Question: Summarize what this figure shows in one sentence.
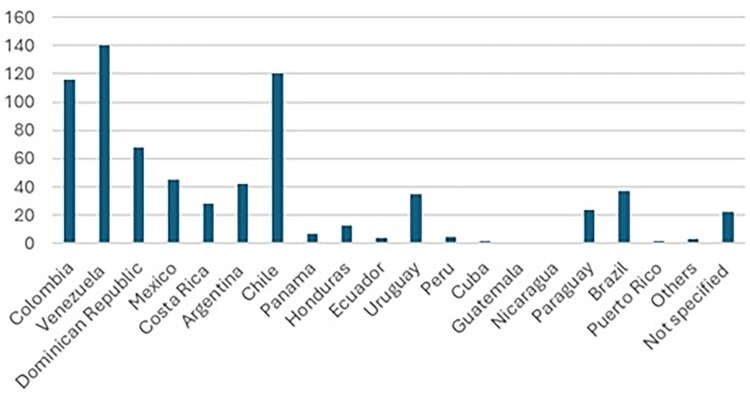
Answer: Distribution of participants by country. IBD = inflammatory bowel disease; PANACEA = PANamerican Crohn’s And Colitis Educational Approach.